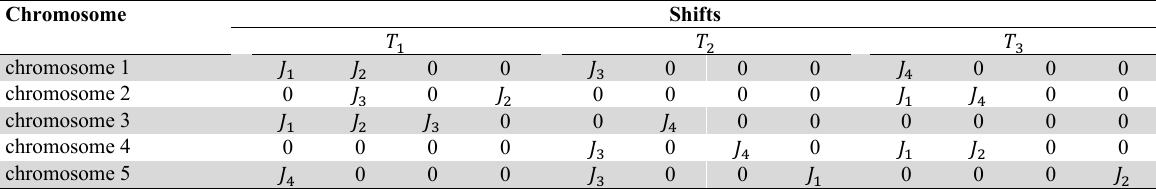
An example population for PSGA Chromosome